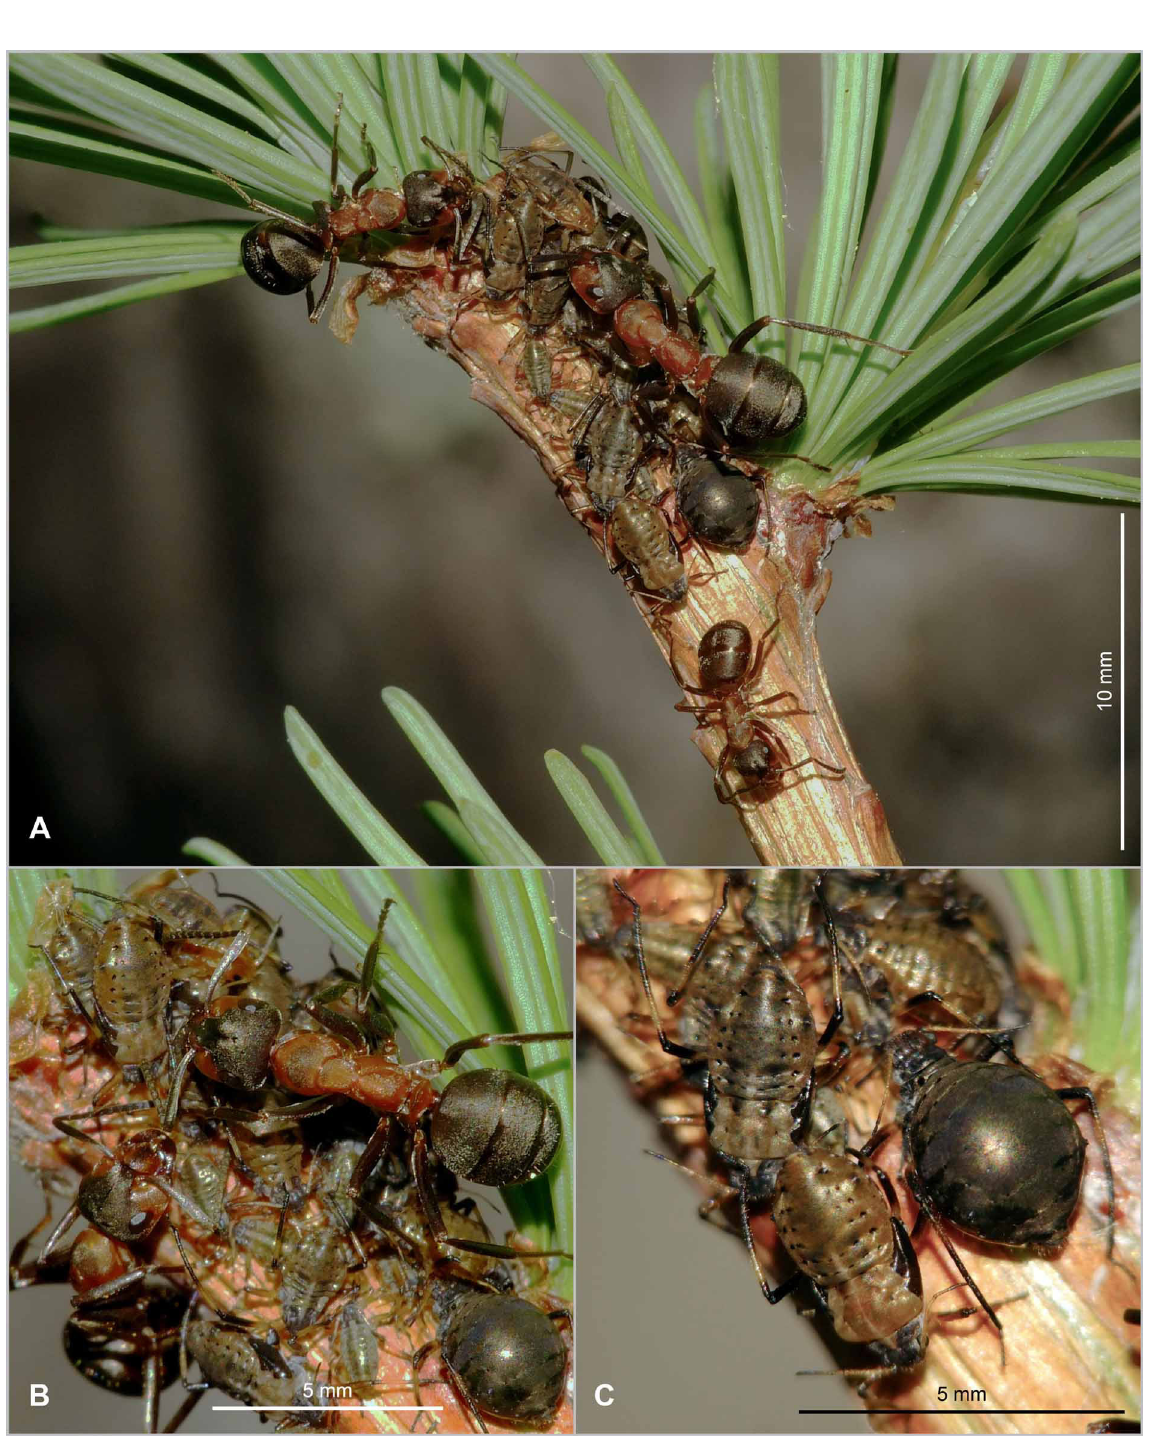
Fig. 66. Cinara (Cinara) cuneomaculata (del Guercio, 1909). Fundatrix with young (mostly alatae) on twig of Larix kaempferi , attended by Formica rufa Linnaeus,